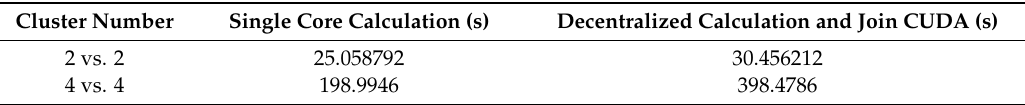
Table 5. Comparison of integrated parallelization simulation